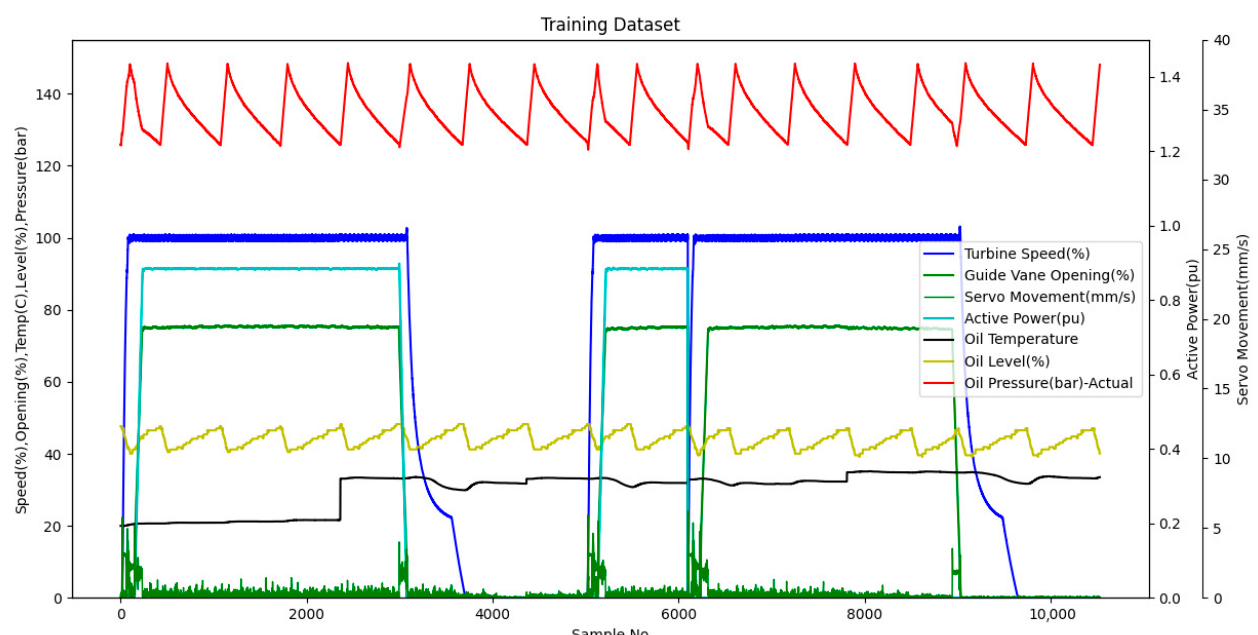
Figure 15. Training dataset without pump